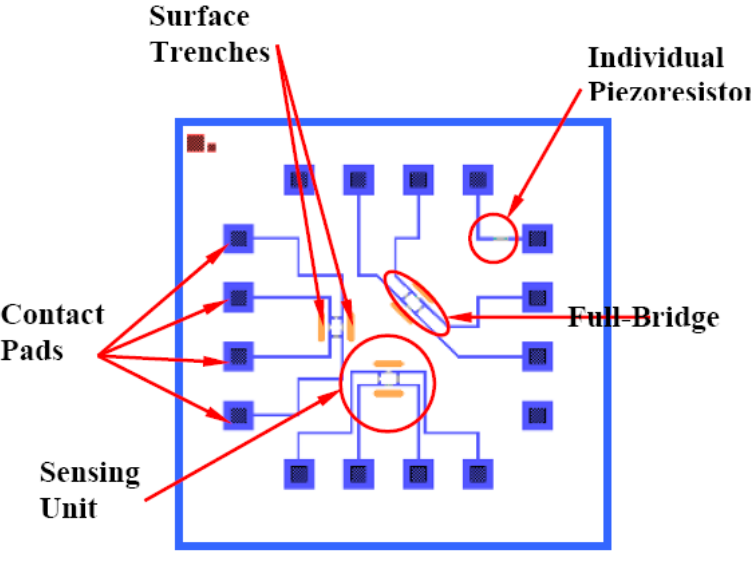
Figure 2. Schematic of the sensing chip design as shown on the microfabrication mask.